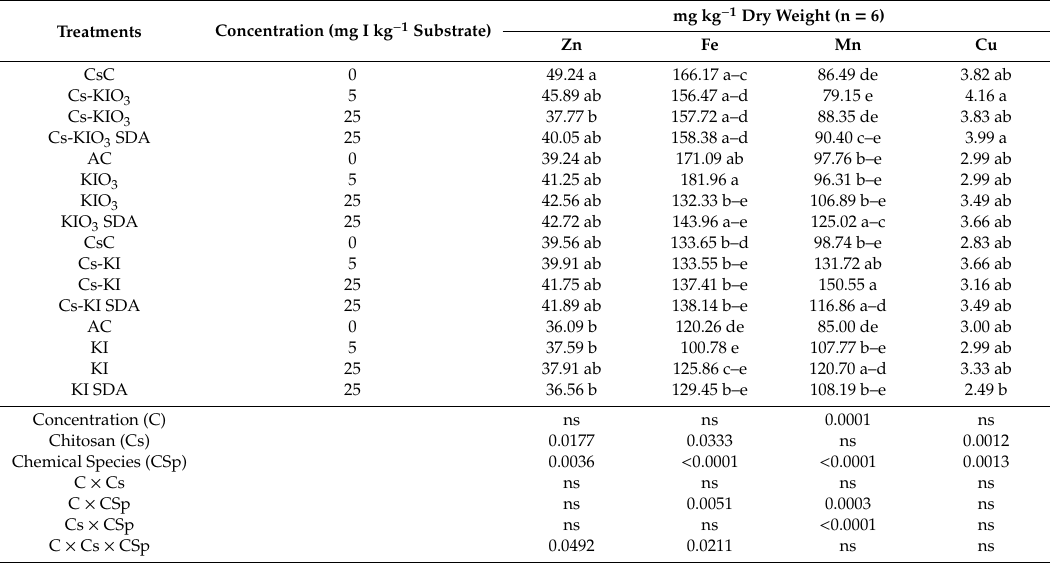
Table 3. Microelement content in mixed samples of lettuce leaves and heads.